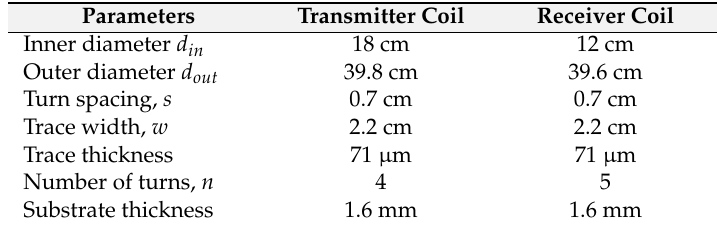
Table 2 . Selected design of the transmitter and receiver coils Table 2. Selected design of the transmitter and receiver coils.